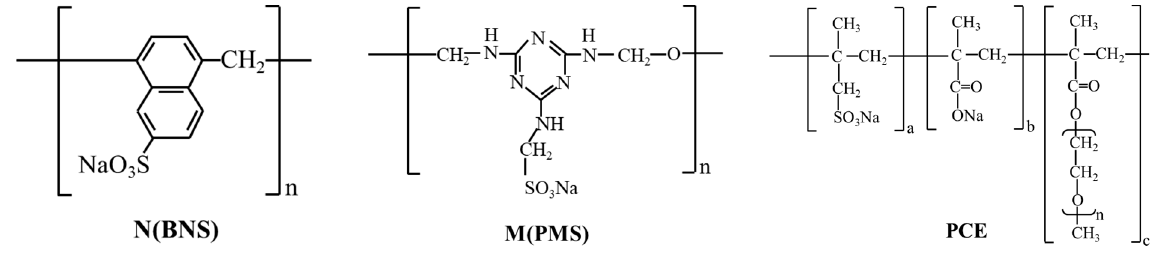
Figure 2. Chemical molecular structure of superplasticizers (N-BNS, M-PMS and PCE). Table 3. Property and classification of different SP used in this study.